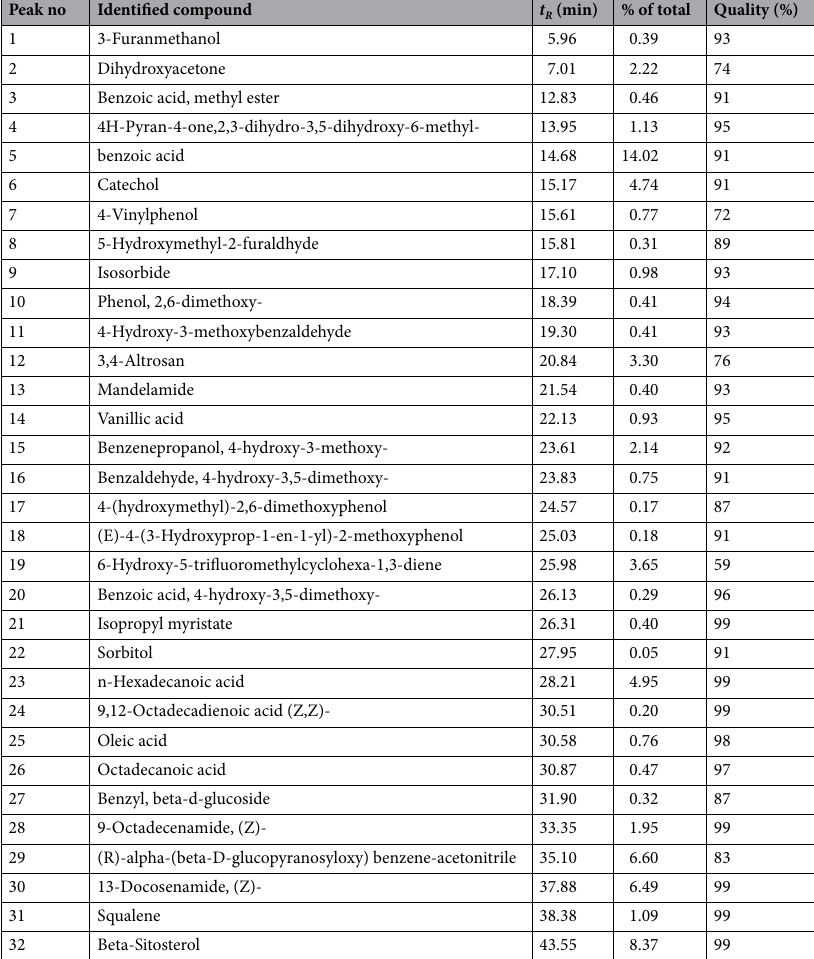
Table 1. Phytochemical components identified in the stem bark of Prunus africana methanolic extract by GC/ MS analysis.